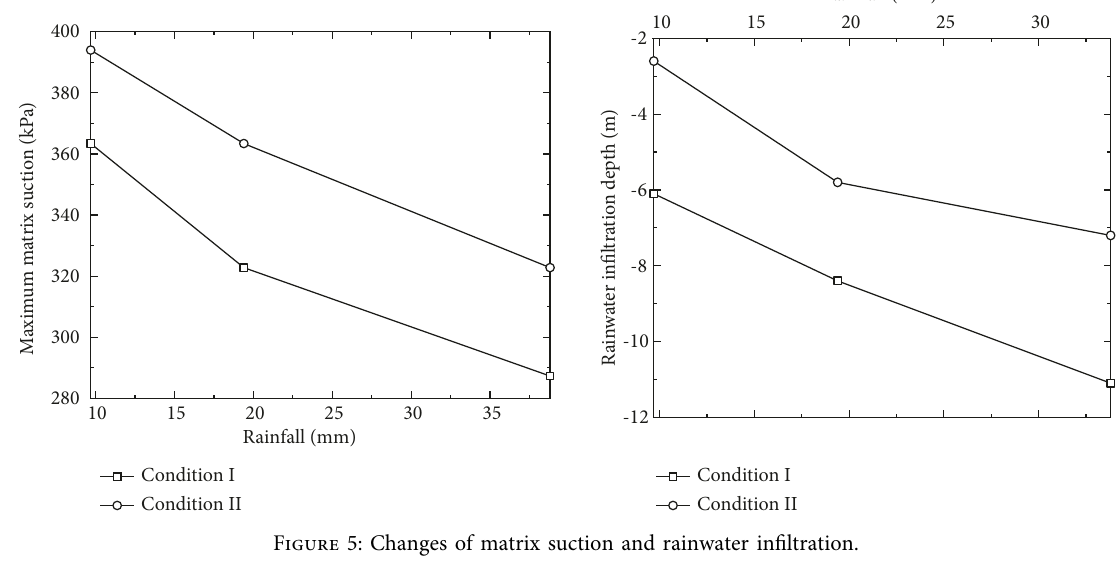
Figure 5: Changes of matrix suction and rainwater infiltration.